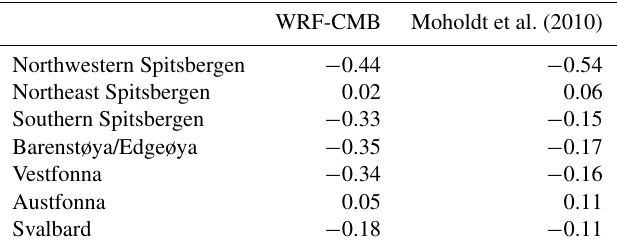
Table 4. Mean surface elevation change rates (myr − 1 ) for 2003– 2008 from WRF-CMB and Moholdt et al. (2010). The Svalbard mean value from Moholdt et al. (2010) used here is the mean of the regions included here (Fig. 1) weighted by